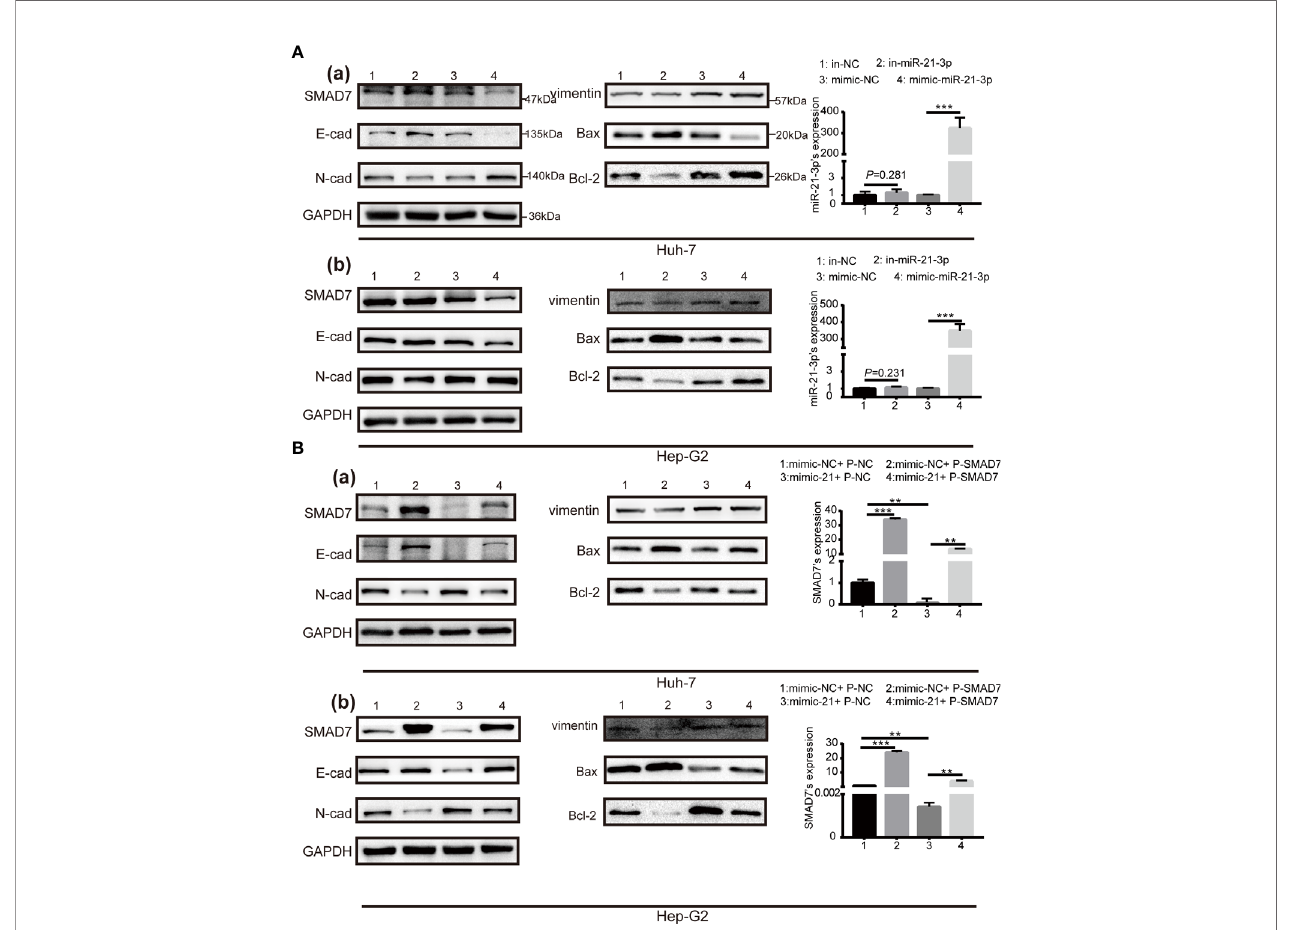
FIGURE 3 | Cell phenotype biomarker variation after SMAD7 transfection with or without miR-21-3p mimics. (A) Western blotting revealing expression of the pro-apoptotic proteins Bax and Bcl-2 and the epithelial – mesenchymal transition (EMT) proteins E-cadherin, N-cadherin and vimentin 48 h after transfection with miR-21-3p inhibitors with or without mimics in Huh-7 (a) and Hep-G2 (b) cells, respectively. Transfection ef fi ciency is listed alongside the image. (B) SMAD7 plasmids (P-SMAD7) were constructed to overexpress SMAD7; plasmids-NC (P-NC) served as control. Transfection ef fi ciency of SMAD7 is listed alongside the image. Pro-apoptotic (Bcl-2, Bax) and EMT (E-cadherin, N-cadherin, vimentin) biomarkers were quanti fi ed after P-SMAD7 and/or miR-21-3p mimic co-transfection in Huh-7 (a) and Hep-G2 (b) cells; photo density in group 1 (mimic-NC+ P-NC) was set at 1. All experiments were performed in triplicate. Data are presented as mean ± SEM. **P < 0.01, ***P <